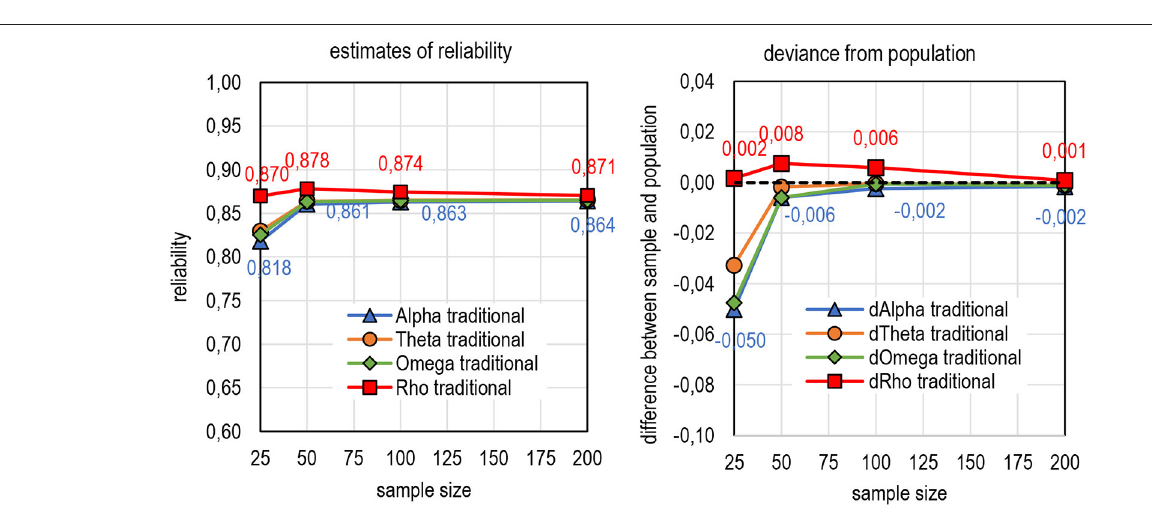
FIGURE 8 | Average estimates of reliability and deviance from the population by sample